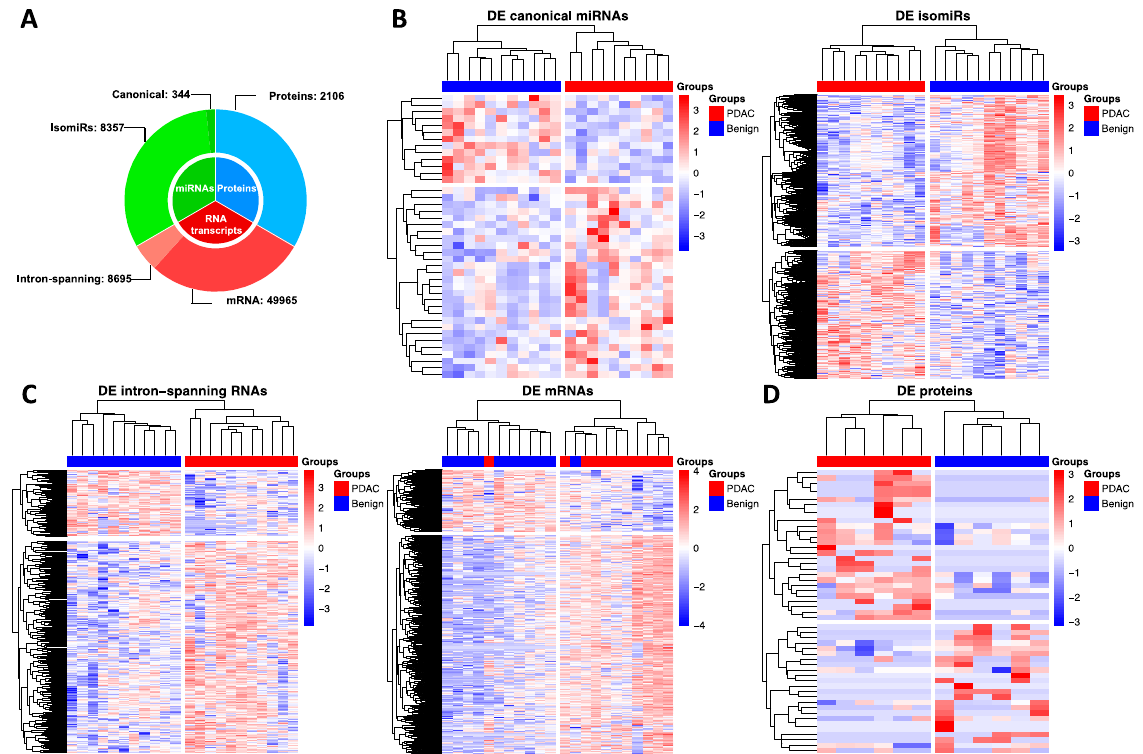
Figure 2. Data summary and differential analysis. ( A ) summary of canonical miRNAs, isomiRs, mRNAs, intron-spanning reads and proteins used in this study for subsequent analysis; ( B ) heatmaps of differentially expressed canonical miRNAs and isomiRs; ( C ) heatmaps of differentially expressed intron-spanning reads and mRNAs; ( D ) heatmap of differentially expressed proteins. Significance level was set to p -value < 0.05 and |Log 2 FC| > 1.